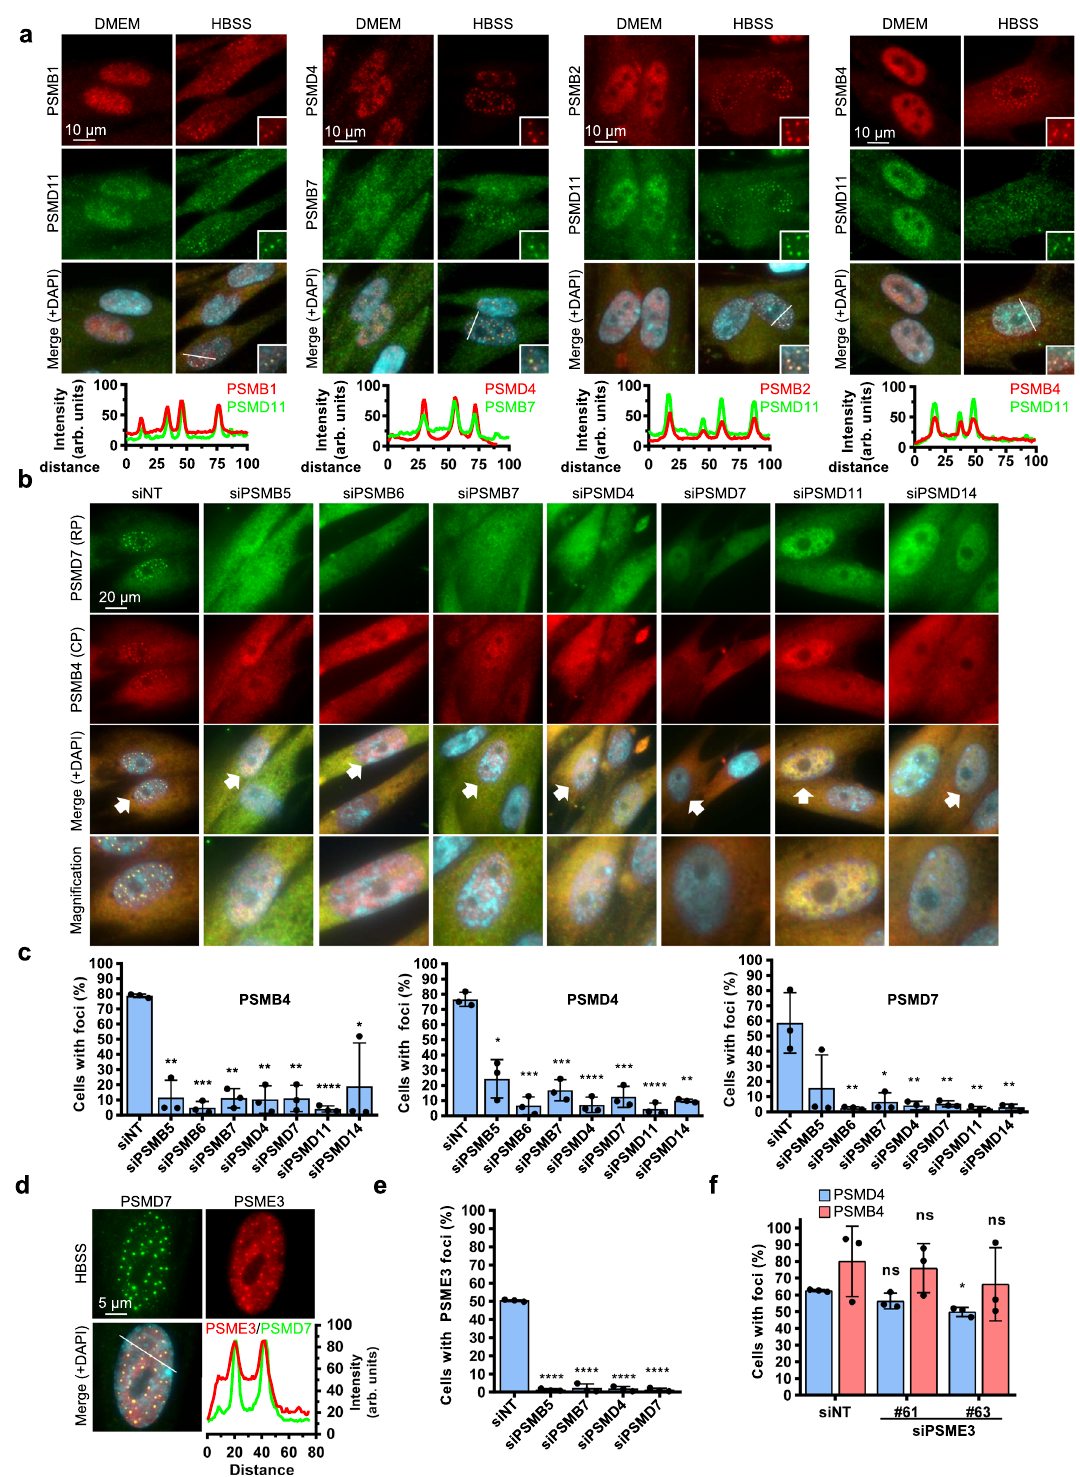
(Fig. 5h – j), three-fold higher for that reported for 53BP1 DNA damage foci 23